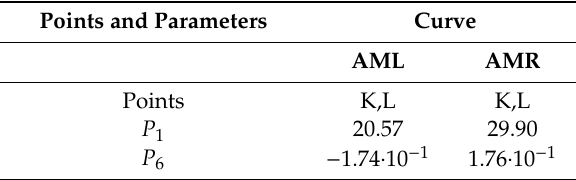
Table 21. P 1 and P 6 for AML and AMR.